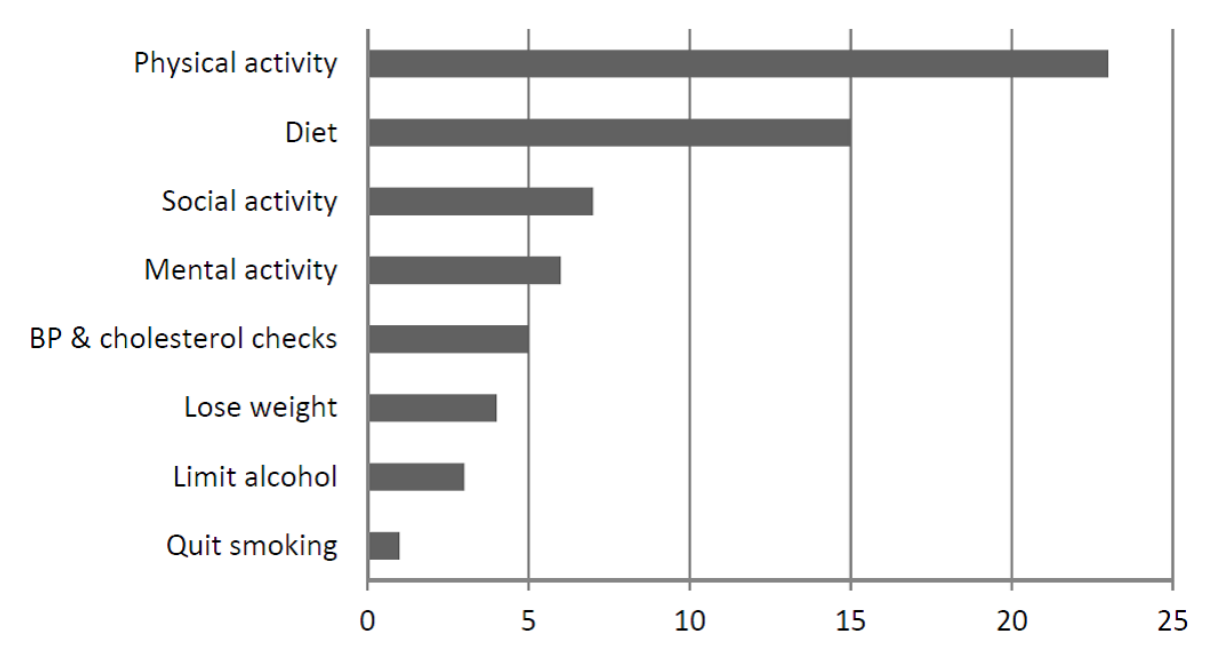
Figure 4. Number of respondents who stated intentions to make improvements in specific areas of behavior.